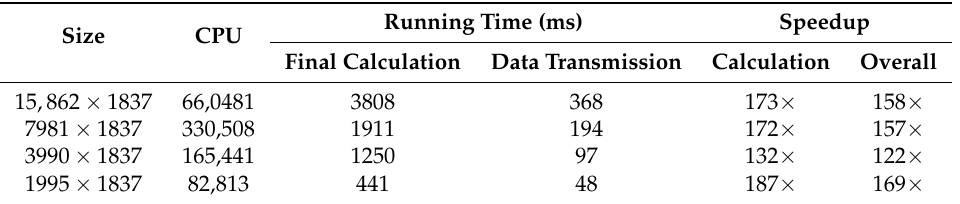
Table 4. Acceleration results of the X-Bragg inversion.